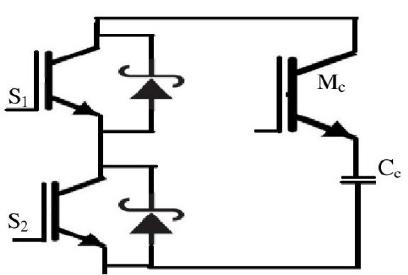
Figure 3. Circuit diagram of the active clamp snubber [9,10].